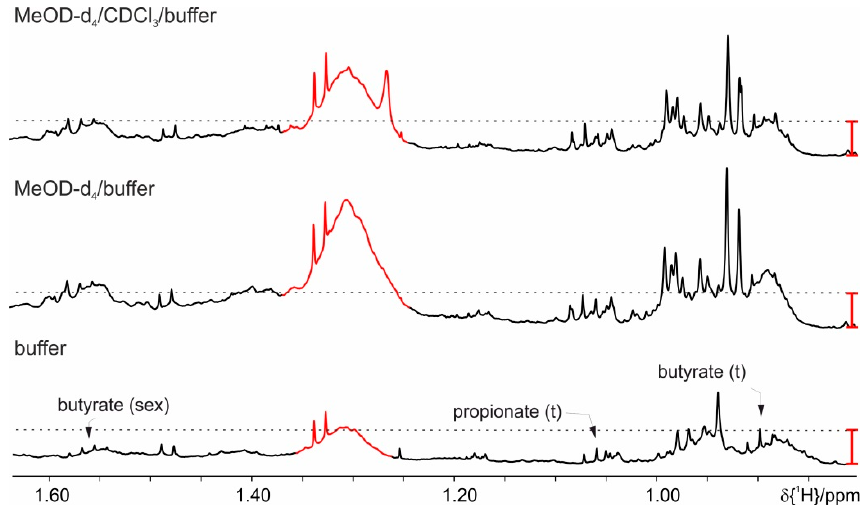
Figure 5. Comparison of different extraction procedures: basic protocol (buffer) and the two-phase extraction protocols (with and without chloroform). The red bar indicates the signal intensity of the extracted background signal at 1.31 ppm and is kept the same for the two-phase protocols.